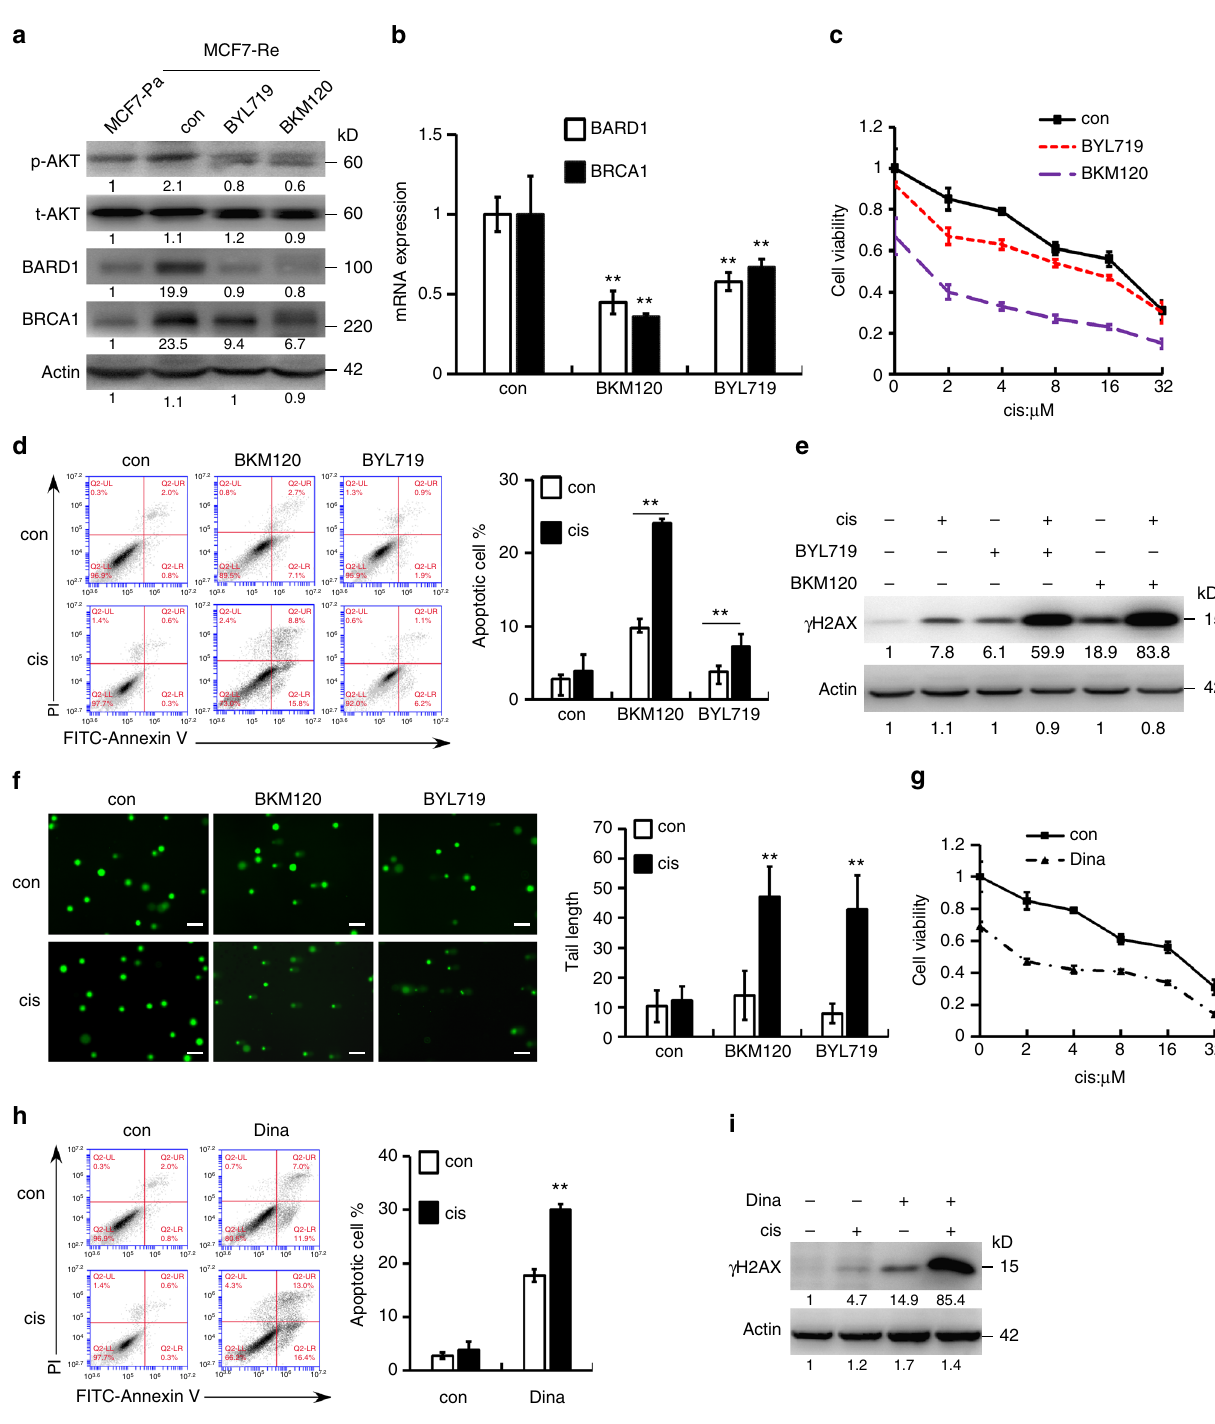
Fig. 4 PI3K inhibition decreases BRCA1/BARD1 expression and sensitizes tamoxifen-resistant cells to cisplatin. a , b The protein ( a ) and mRNA ( b ) expression of BARD1/BRCA1 in MCF7-Re cells treated with BKM120 or BYL719. c – f MCF7-Re cells were treated with control, BKM120, or BYL719 and then treated with cisplatin. The sensitivity to increasing concentrations of cisplatin ( c ), apoptotic cells ( d ), γ H2AX expression ( e ), and DNA damage shown by comet assay ( f ) were measured. Scale bar indicated 100 μ m. g – i MCF7-Re cells were treated with Dinaciclib and cisplatin. The sensitivity to increasing concentrations of cisplain ( g ), apoptotic cells ( h ), and γ H2AX expression ( i ) were measured. In b – d , f – h , data show means± s.d. ( n = 3) ** p < 0.01 compared with control by Student ’ s t